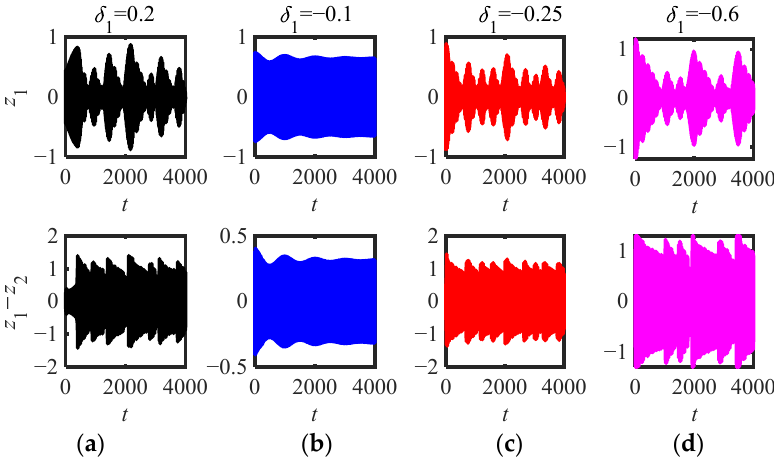
Figure 13. Time-domain response of (5) (parameters in Figure 11a m 2 = 0.3, μ = 2, κ = 0.11): ( a ) δ 1 = 0.2,